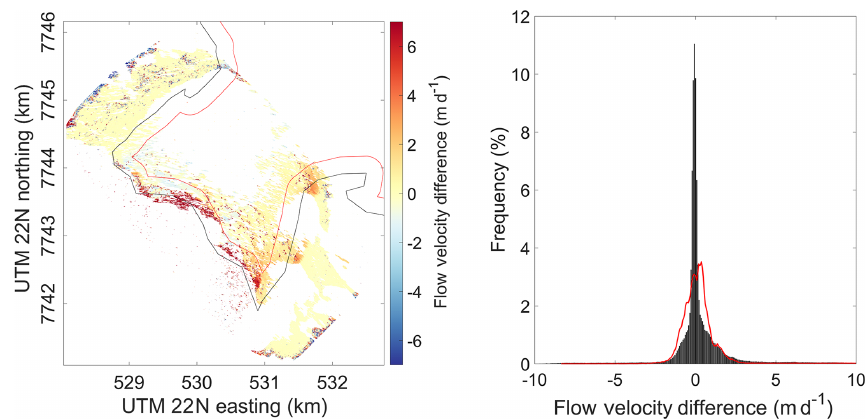
Figure 9. Distribution of flow velocity differences derived from UAV image matching and TRI interferometry. Positive values (red colours) depict higher estimated flow velocities from UAV, and negative values (blue colours) depict higher derived velocities for the interferometric TRI measurements. Only values inside the glacier’s marginal boundary (black line) were included in the histogram. The red line in the histogram shows the distribution of values when a 250m buffer zone at the glacier’s margins was excluded. Note the velocity differences are from the line-of-sight components of the